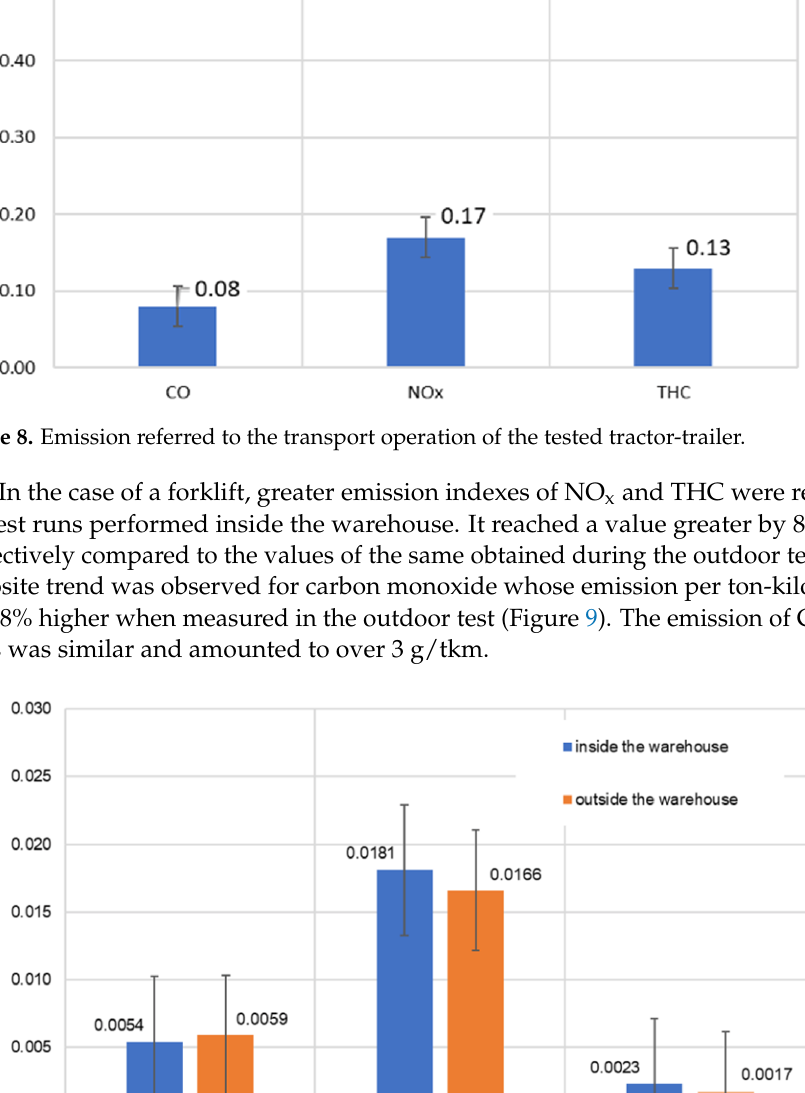
Figure 9. Comparison of the emissions referred to the handling operation of the tested forklift.